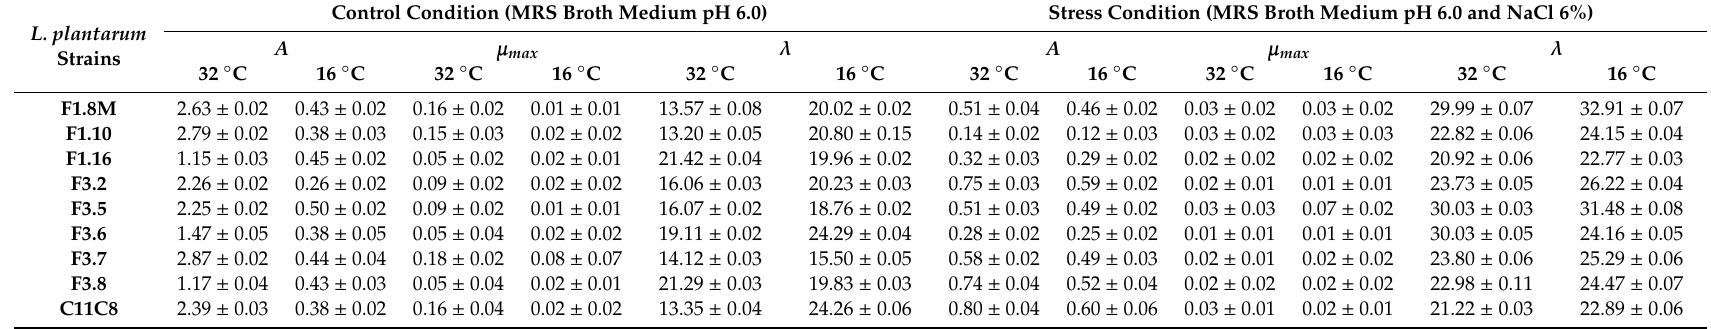
Table 1. Growth Parameters, Calculated by Gompertz’s Equation of L. plantarum Strains under Control Conditions (MRS Broth Medium pH 6.0) and under Stress Condition (MRS Broth Medium pH 6.0 and NaCl 6%) at 32 ◦ C and 16 ◦